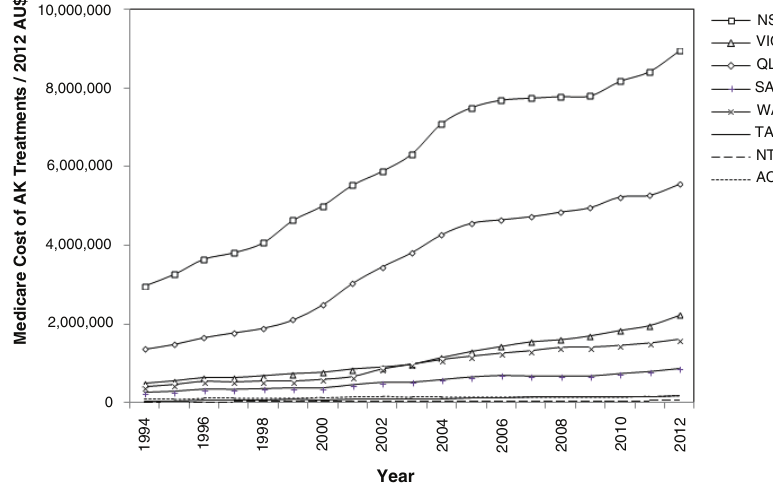
Figure 5. Total benefits paid for item number 30192 for each Australian state and territory (2012 AU$).